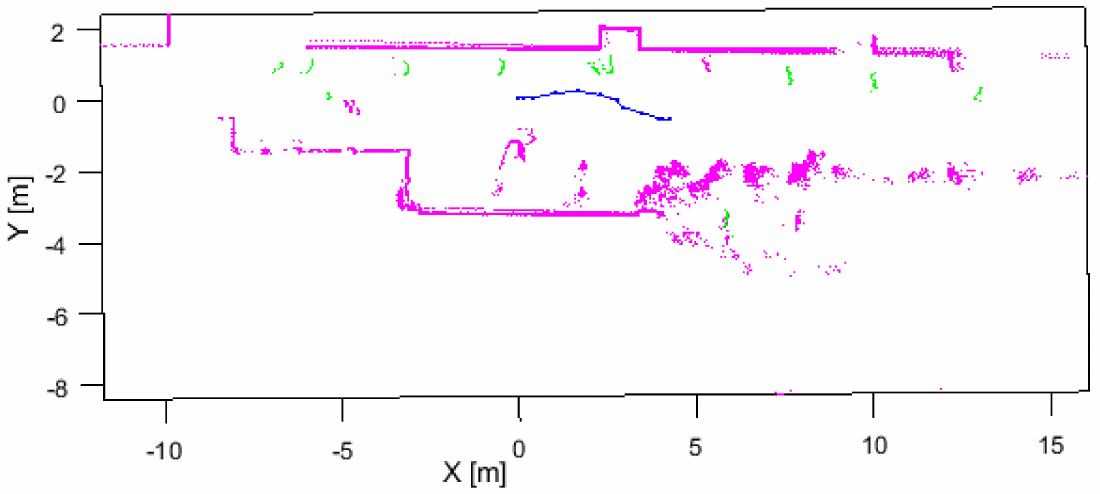
Figure 17. Simultaneous mapping and identification of dynamic